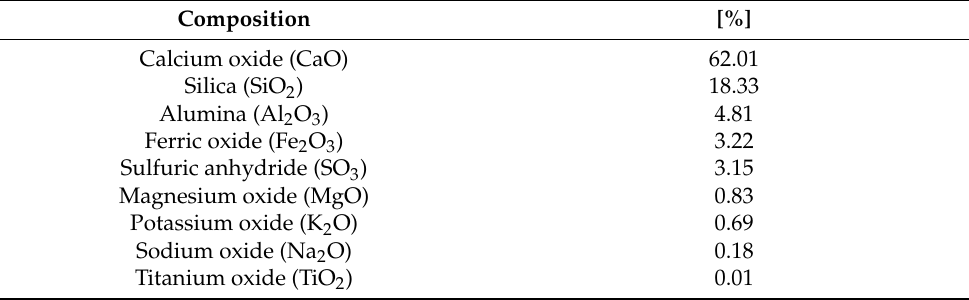
Table 4. White cement (BL II/A-L 42.5 R) chemical composition.